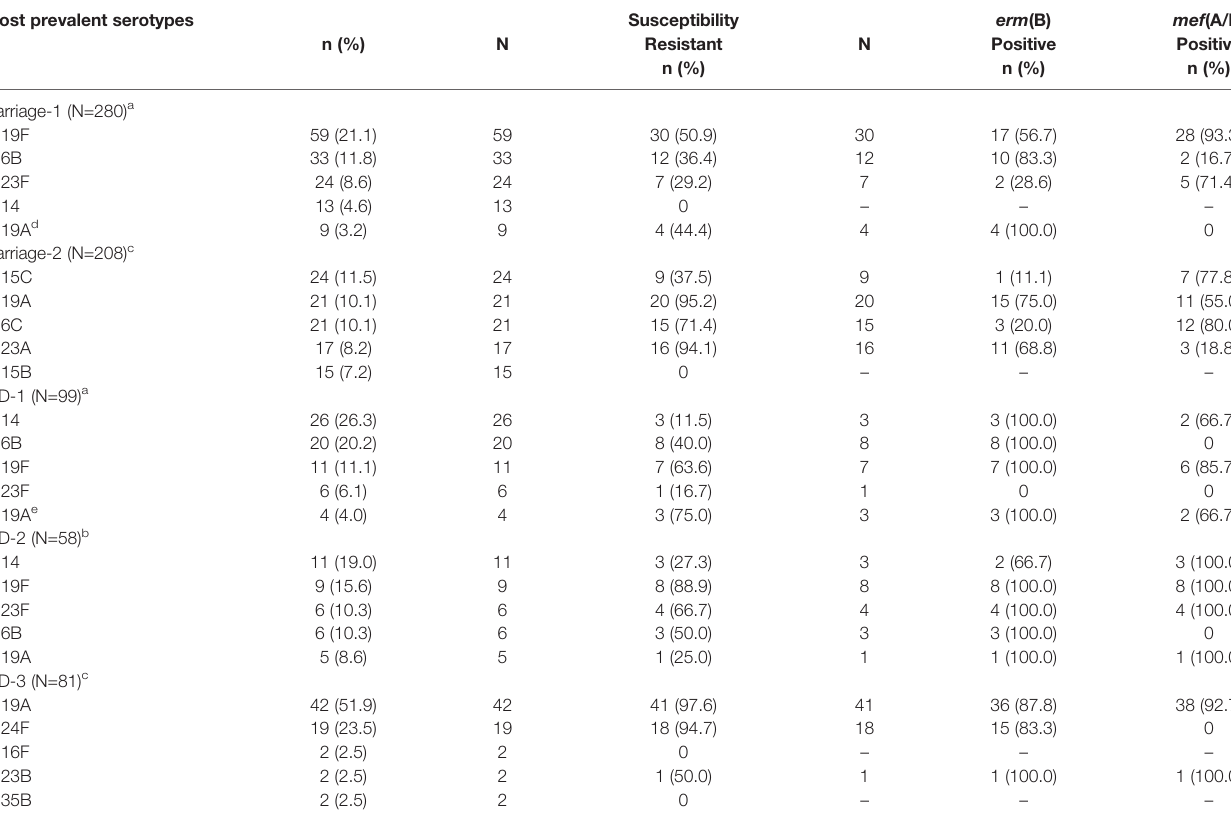
TABLE 3 | Most prevalent pneumococcal serotypes, macrolide resistance and genes in carriage and IPD. Most prevalent serotypes